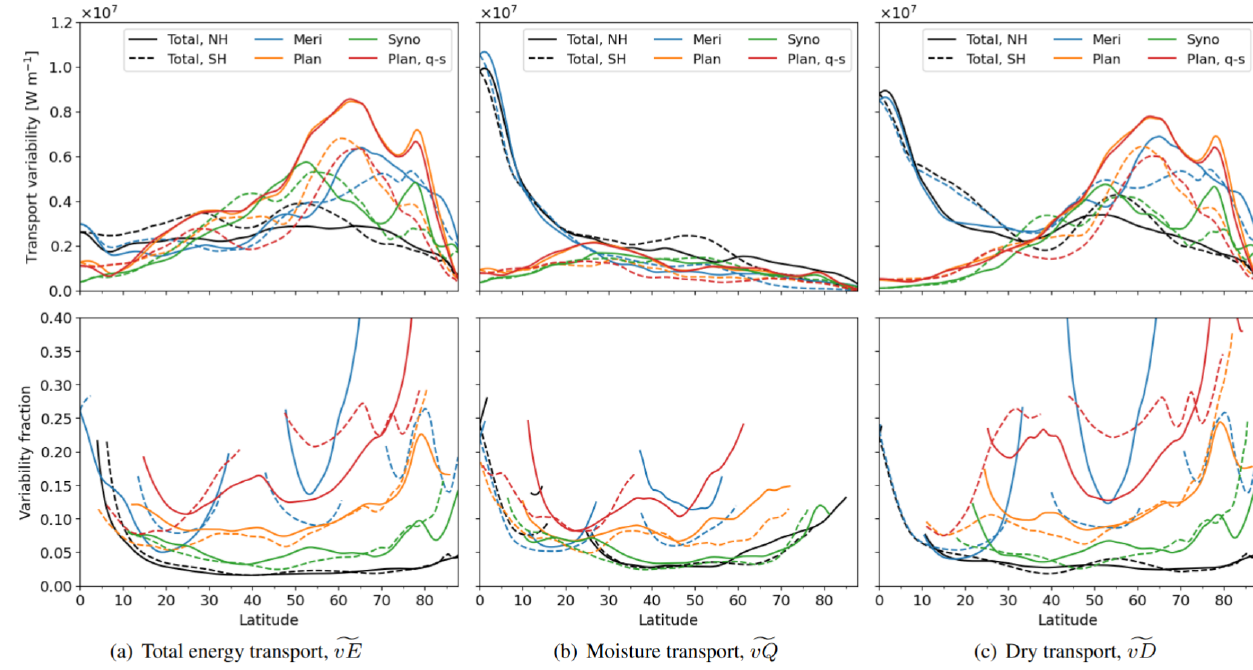
Figure 7. ( a , upper panel) Inter-annual variability in the meridional energy transport, computed as the standard deviation in the annual transport, from ERA5 for the years 1979–2021 (black). The energy transport is divided into the meridional overturning circulation (blue) and wave components at the planetary (orange) and synoptic (green) scales. Solid and dashed lines depict the Northern Hemisphere and Southern Hemisphere, respectively. ( a , lower panel) The fraction of the variance of each transport component related to its absolute mean transport. Values are masked at latitudes ± 5 ◦ where the mean transport crosses zero or where the absolute mean is smaller than 5% of the zonal maximum of the total transport. (b, c) As panel (a) but for the latent and dry energy